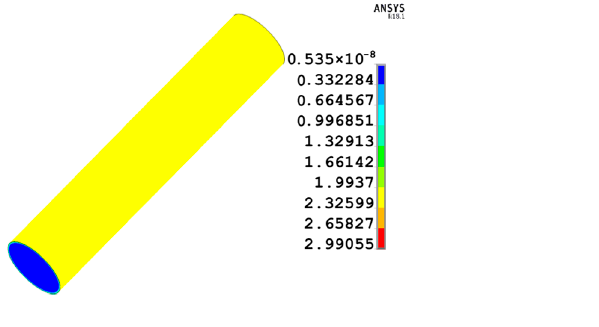
Figure 4. The contour plot of the magnetic field: ( a ) steel bar; ( b ) one quarter of cross-section.